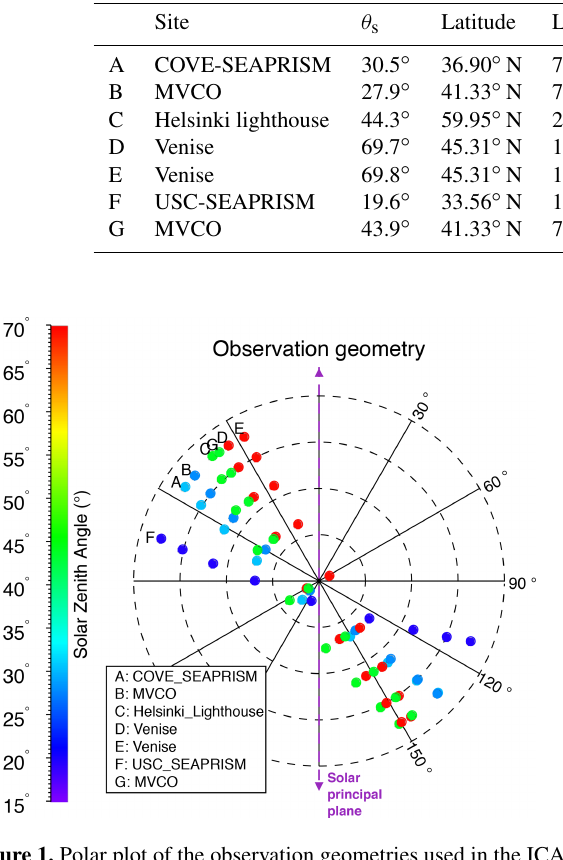
Figure 1. Polar plot of the observation geometries used in the ICA, corresponding to AERONET-OC and MISR coincident observa- tions. The angular coordinate indicates φ , while the radial coordi- nate indicates θ v (each dashed concentric circle represents 20 ◦ ). θ s is indicated by color. The purple dashed line indicates the solar prin- cipal plane, where φ = 0 ◦